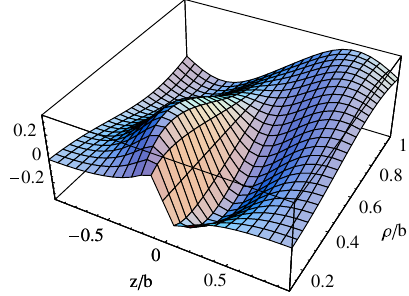
=b for in units of E 2 0 a 3 z d